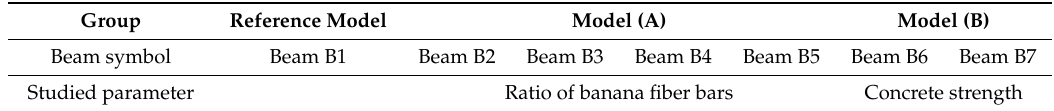
Table 3. Studied parameters.